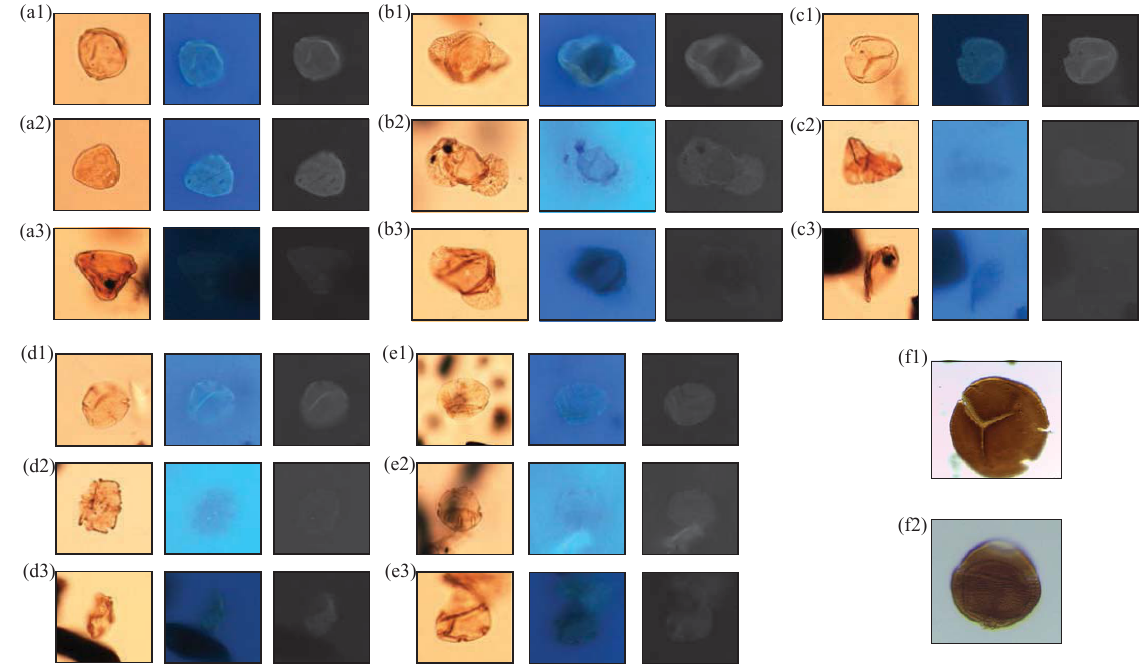
Figure 3. Images of Eocene, Oligocene, and Miocene pollen and spore taxa analysed under white light, UV fluorescence, and red filter. The red filter shows better contrast between the grain and the background. (a) Myricipites harrisii : (a1) Miocene, slide 15R-6W,